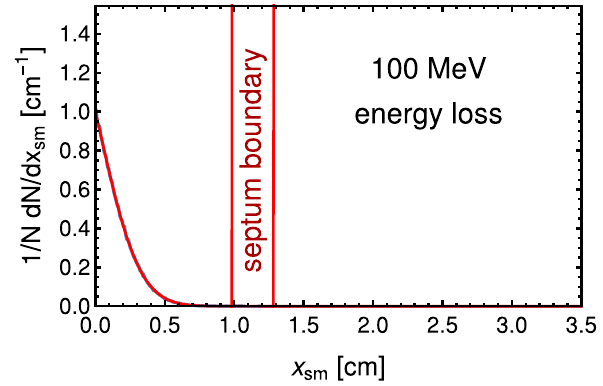
Fig. 7 Transverse coordinate distribution of the beam at the position of the septum magnet with the condition of a constant angular kick of thedeflectiondeviceof1.75mrad,takingintoaccounttheenergylossin the deflection device of 100 MeV. The vertical lines indicate the septum magnet boundary. The red curve indicates the result of a Gaussian